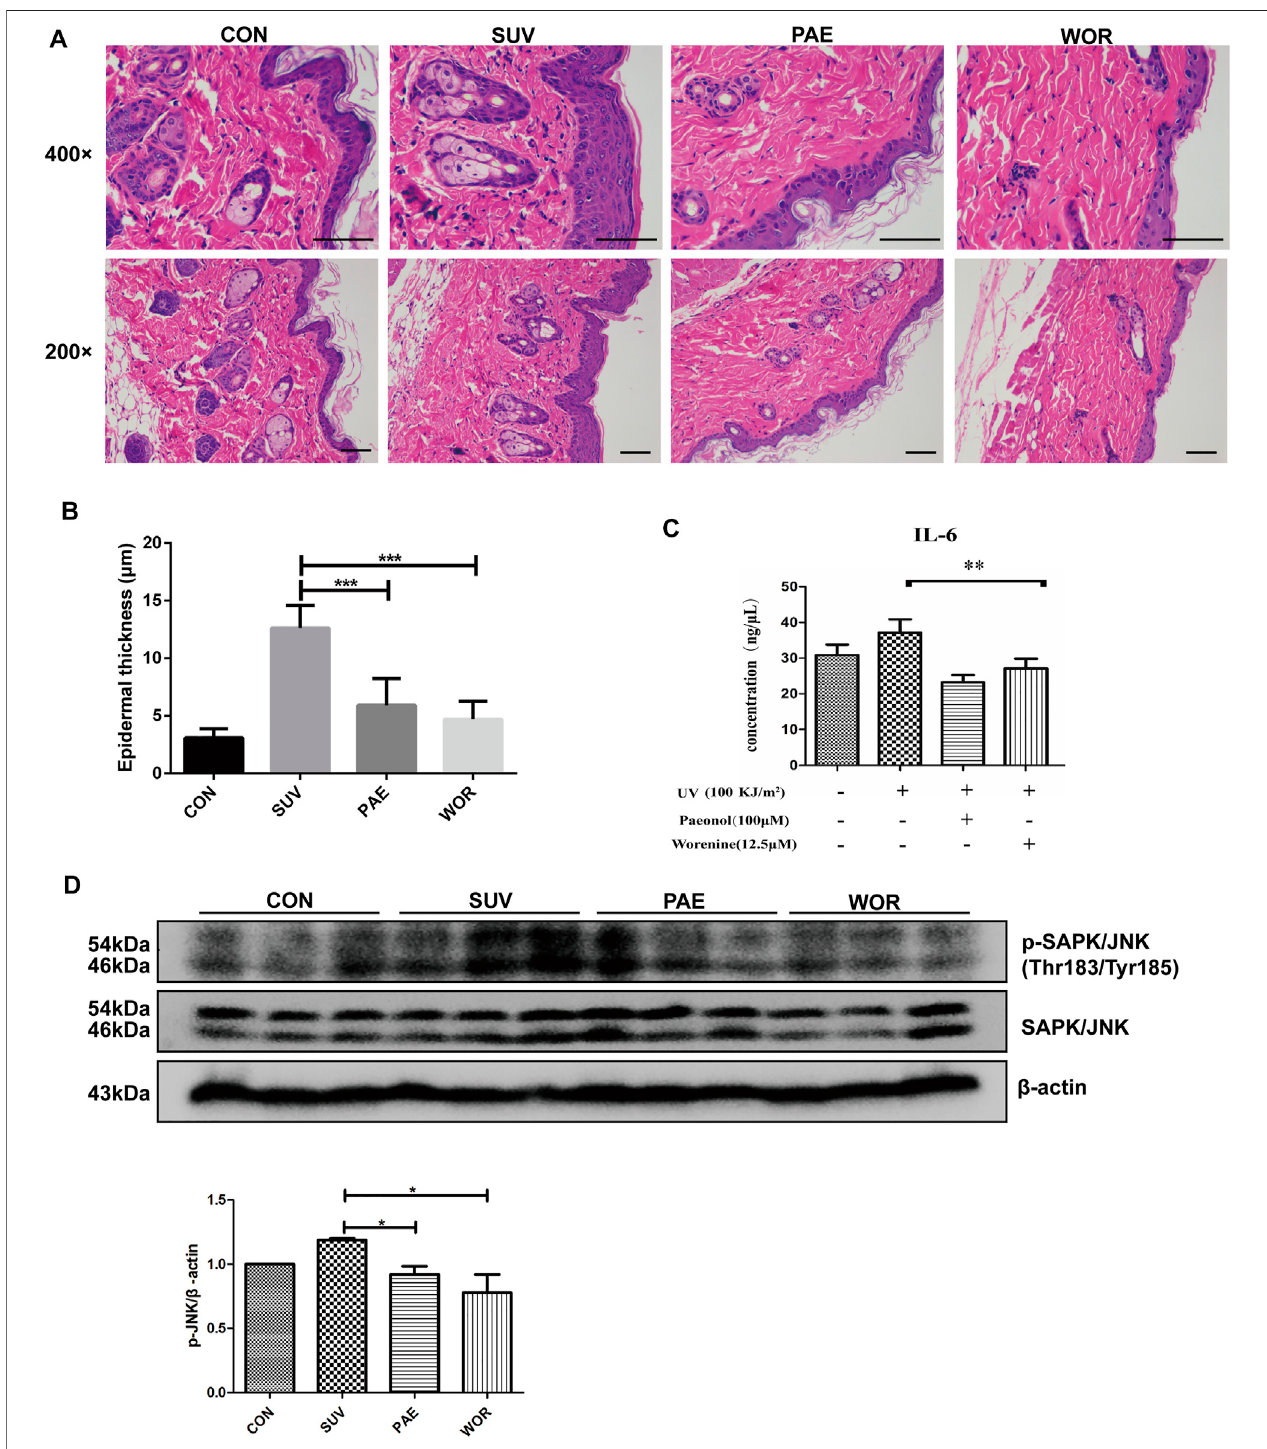
FIGURE 4 | Worenine inhibits SUV-induced sunburn and JNK activation in a mouse model. (A) The back skin was taken for H&E staining analysis in the mouse modelofSUV-inducedsunburn.Scalebar:10 μ m. (B) TheepidermalthicknessofthebackskinwasanalyzedusingImageJsoftware.Thedataarepresentedintheform of (cid:1) X ±SD,* p < 0.05,** p < 0.01, *** p < 0.001. (C) Theback skin wastakentodetect IL-6secretionusing ELISAassayinthemouse modelofSUV-induced sunburn. The data arepresented in theformof (cid:1) X ±SD, * p < 0.05, ** p < 0.01,*** p < 0.001. (D) The backskin wastaken todetect thephosphorylationlevelofJNKusing Western blot in the mouse model of SUV-induced sunburn. The data are presented in the form of (cid:1) X ± SD, * p < 0.05, ** p < 0.01, *** p < 0.001.